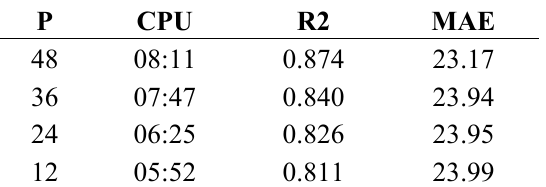
Table 10. Comparison between different P’s when Q = 97 (Byberry,